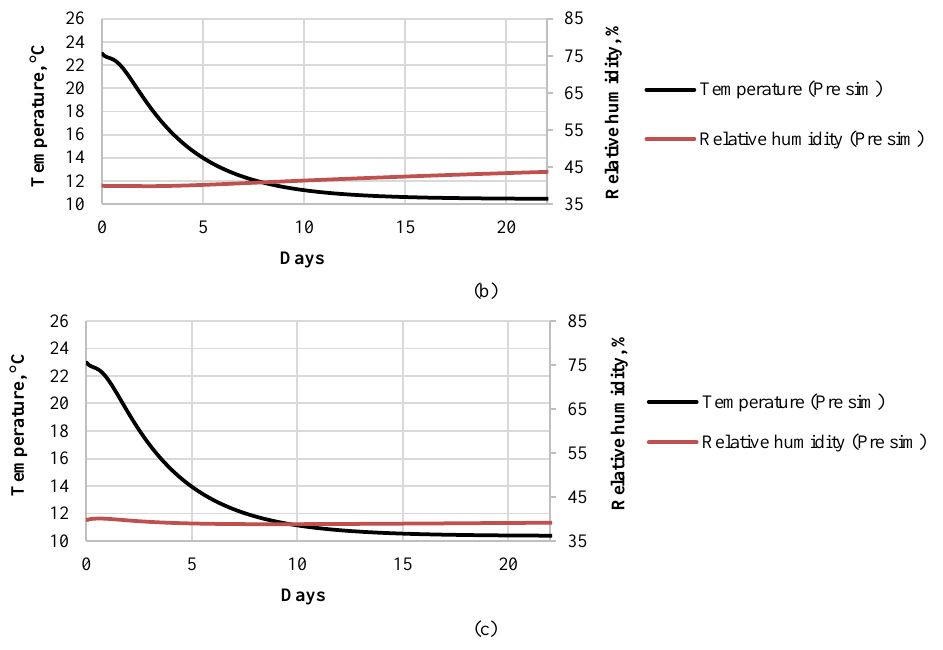
Fig. 4. Simulated temperature and relative humidity between masonry and insulation layer before experiment: a) wood fiber, b) EPS, c) mineral